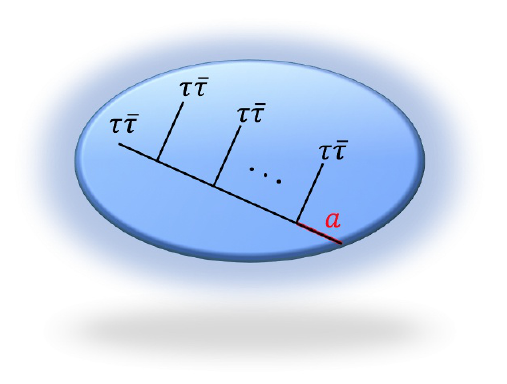
Figure 3 . (Color online.) A sketch of the basis states of multi- (cid:28) (cid:22) (cid:28) Hilbert space on a disk. The line a in red represents either 1 or (cid:28) (cid:22) (cid:28) .